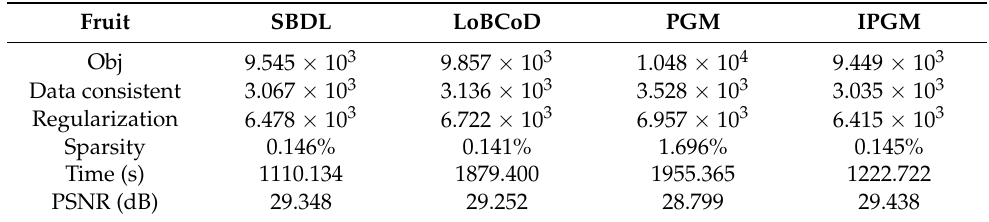
Figure 1. Comparison of the average function values obtained over four trials versus the number of iterations for learning 100 atoms with sizes of 11 × 11 from the grayscale natural fruit images. Table 1. The experimental results obtained by all compared methods after 1000 iterations with the grayscale natural fruit